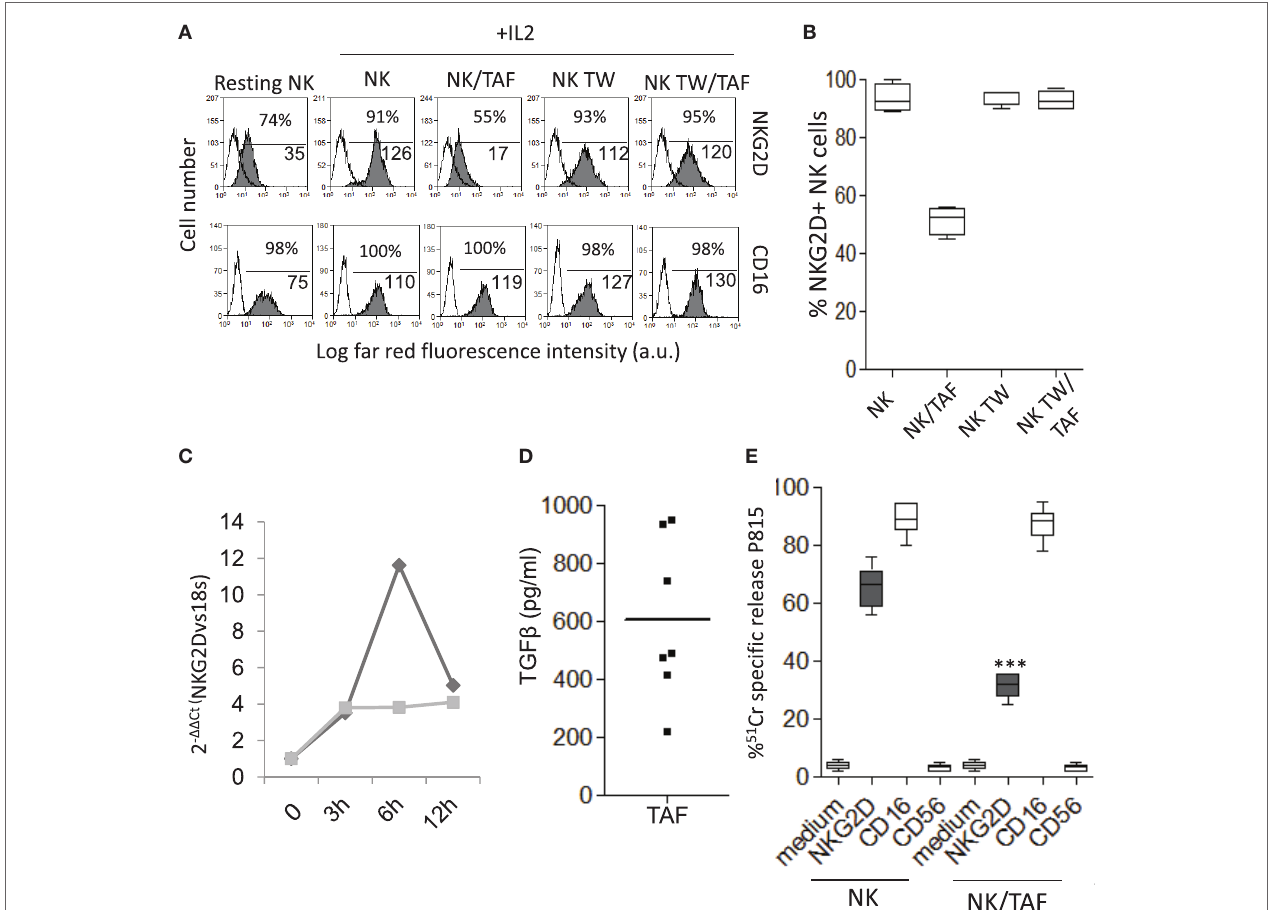
FigUre 2 | Tumor-associated fibroblasts (TAF) regulate the expression and function of NKG2D on activated natural killer (NK) cells. (a) NK cells were cultured with IL-2 for 6 days in contact with TAF (NK/TAF), or in the upper chamber of a transwell plate containing TAF in the lower chamber (NK TW/TAF), and analyzed for the expression of NKG2D (upper row, gray histogram) or CD16 (lower row, gray histogram) by immunofluorescence with the specific monoclonal antibodies (mAbs) followed by Alexafluor647 anti-isotype antiserum and FACS analysis. White histograms: cells labeled with the anti-isotype antiserum alone. NK alone (NK) or cultured in the transwell (NK TW) and freshly isolated (resting) NK were analyzed as controls. In each subpanel: percentage and the mean fluorescence intensity (MFI, a.u.) of positive cells. Results are expressed as Log far-red fluorescence intensity vs number of cells. (B) Percentage of NKG2D positive cells among NK cells alone (NK) or co-cultured with TAF (NK/TAF) in contact or separated by transwell (NK TW, NK TW/TAF). (c) IL-2-mediated upregulation of NKG2D mRNA was analyzed in NK cells alone (dark gray) or co-cultured with TAF (light gray), by quantitative real-time PCR at the indicated time points (0, 3, 6, and 12 h). Results are expressed as 2 −ΔΔ CT and are representative of three independent experiments. (D) Transforming growth factor (TGF) β was measured by ELISA in the supernatant of TAF from six patients. Results are expressed as picogram per milliliter. (e) Reverse cytolysis (ATCC) of the target P815 cell line exerted by NK cells alone (NK) or co-cultured with TAF (NK/TAF), in the absence or presence of mAbs to the indicated NK cell surface molecules. Results are shown as percentage of 51 Cr-specific release. (B,e) Mean with boxes and whiskers min to max of six experiments with NK cells derived from six distinct co-cultures with donor matched TAF. In each panel: *** p < 0.0001; ns, not